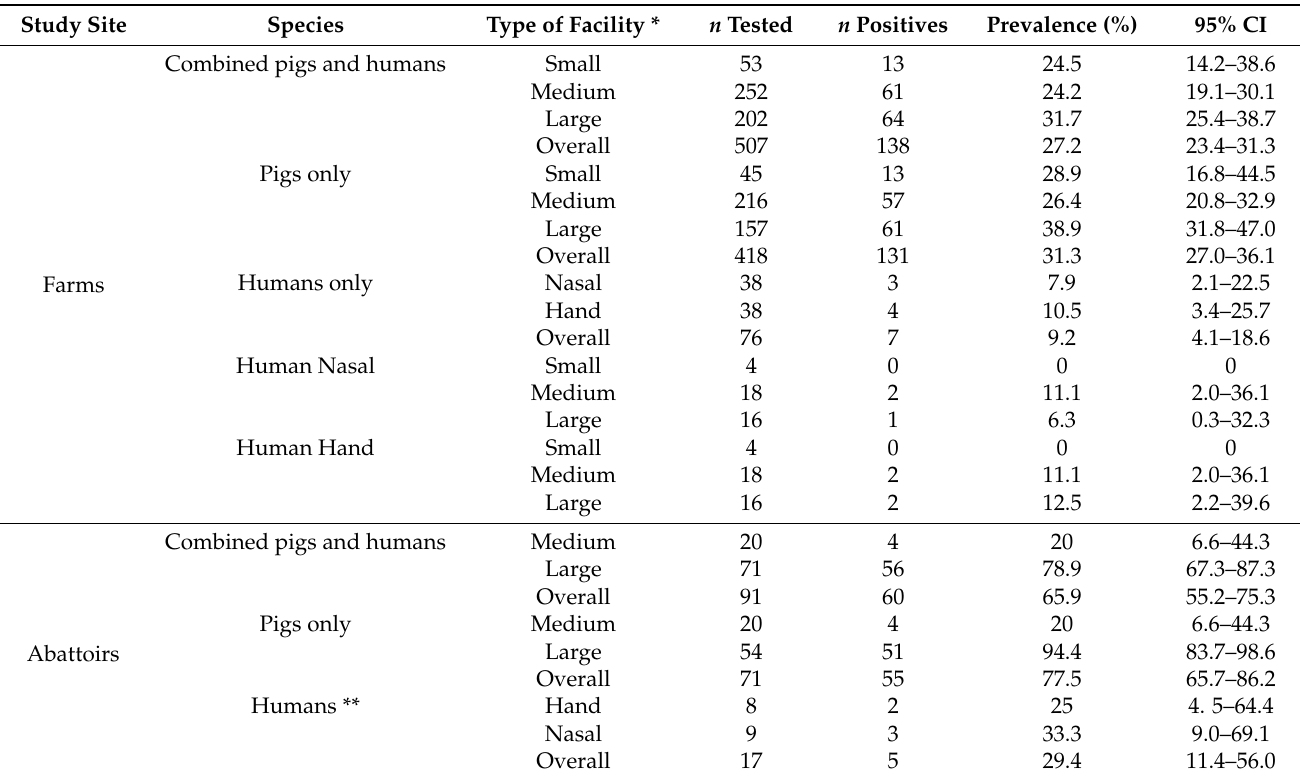
Table 2. Prevalence of S. aureus in pigs and humans at farms and abattoirs.